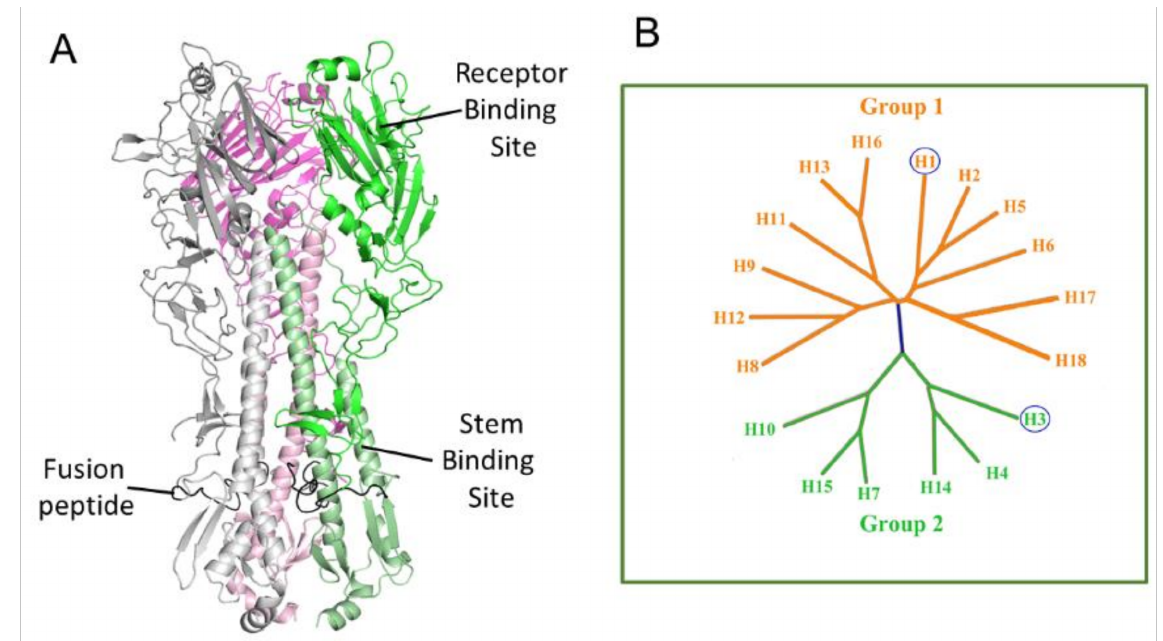
Figure 1. ( A ) Structure and ( B ) phylogenetic tree of